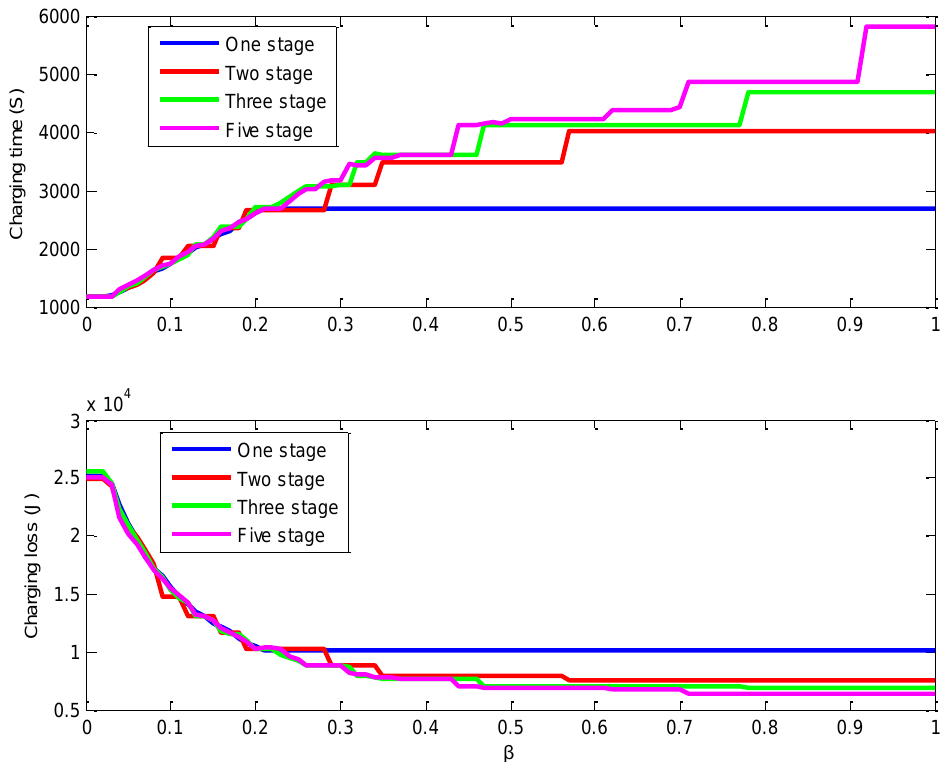
Figure 10. The charging time and charging loss change with the variation of β under different charging stages.